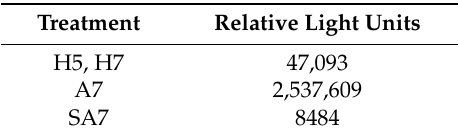
Table 3. Measure of ATP in solution as indicated by Relative Light Units